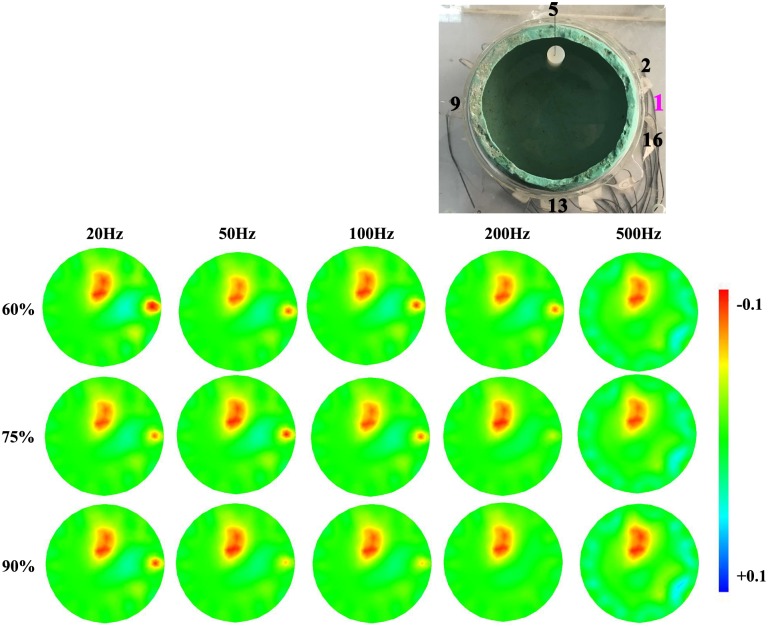
Reconstructed results of the ischemic stroke and the effects of the contact impedance.The contact impedance imbalance was simulated by varying the resistor in series with Electrode 1.